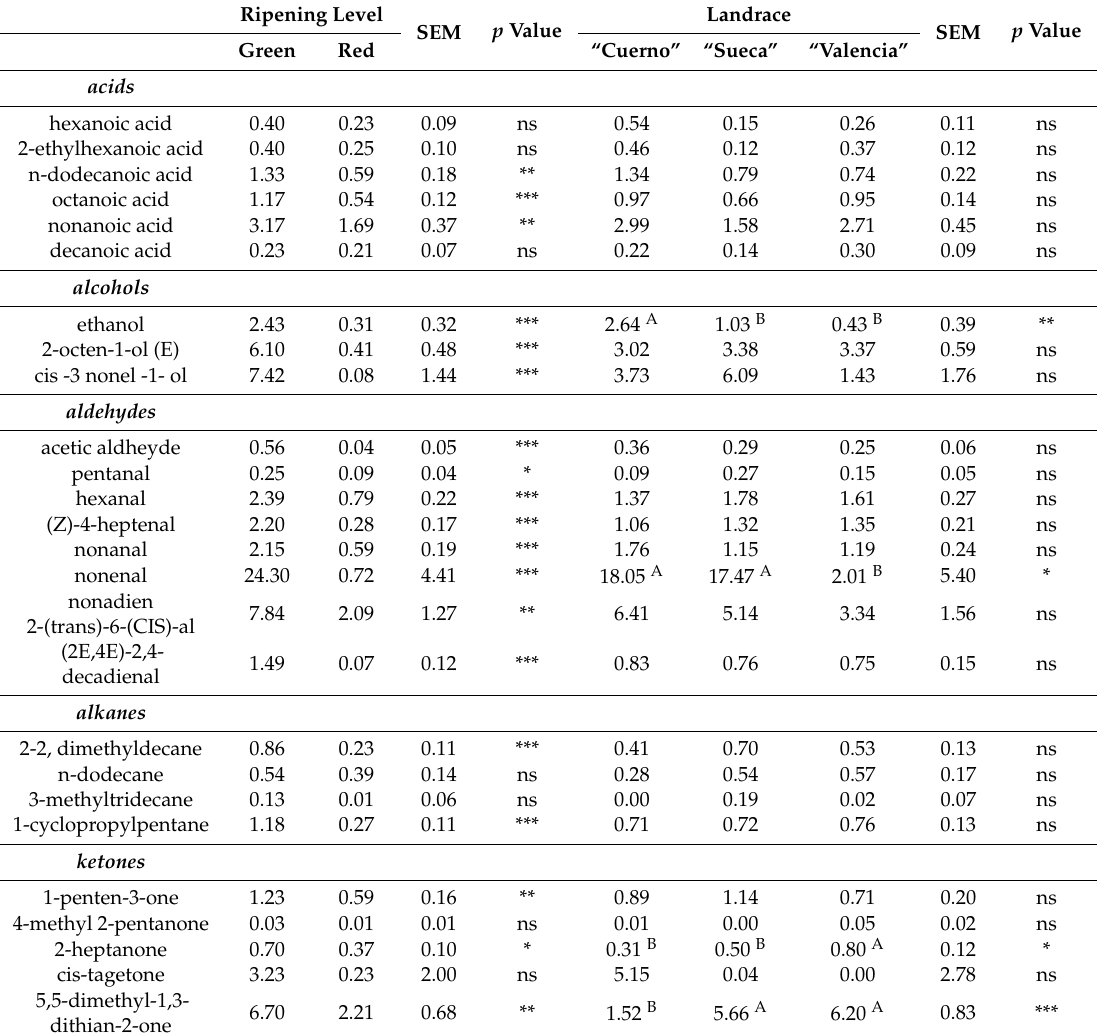
Table 4. E ff ect of ripening and landrace on the volatile profile of